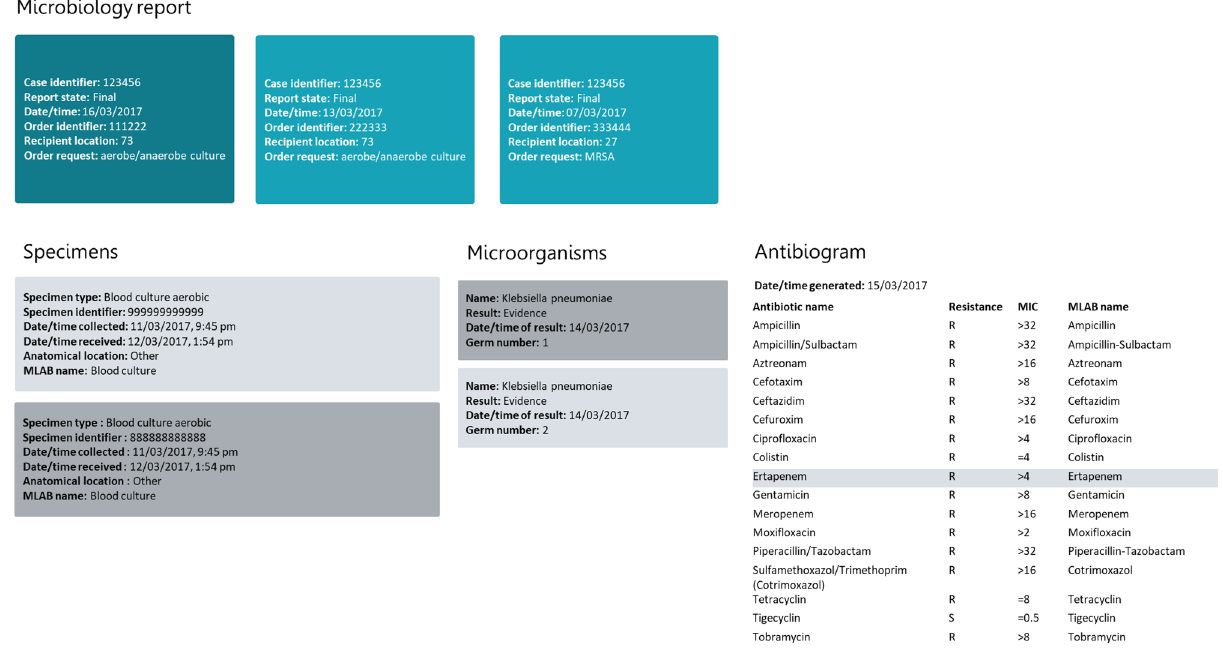
Figure 4. Microbiology report of the selected encounter, visualised in the openMibi application (1) Overview of three microbiology reports with case identifier, report state, date/time, order identifier, recipient location, order request, (2) specimens contained in selected report with specimen type, specimen identifier, date/time collected, date/time received, anatomical location, (3) microorganism found with species identification, result, date/time of result, bacterial count, (4) corresponding antibiogram with date/time generated, standardized antibiotic name, resistance, minimum inhibitory concentration and the original antibiotic substance name in the primary